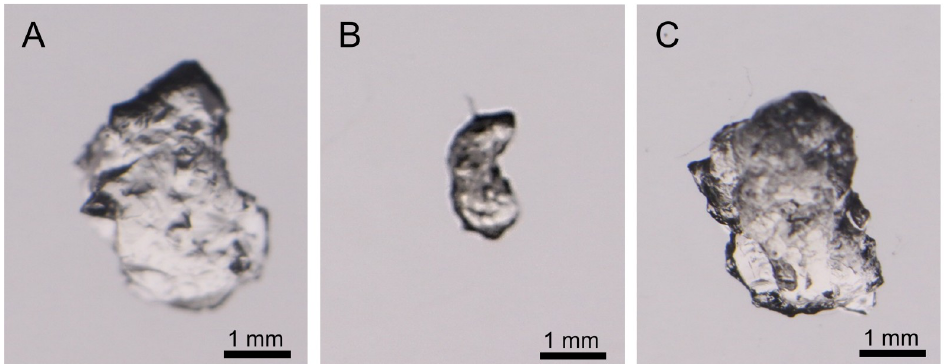
Fig 1. Microscopic images of apoferritin hydrogels. (A) Swelled, (B) dried, and (C) reswelled.